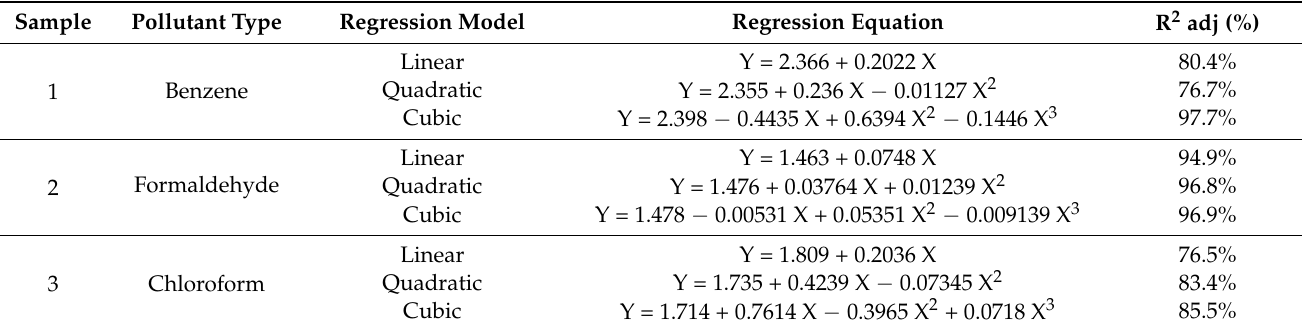
Table 7. The orthogonal polynomial regression model for the absorption ability of pollutants from the mortar with OPS-activated